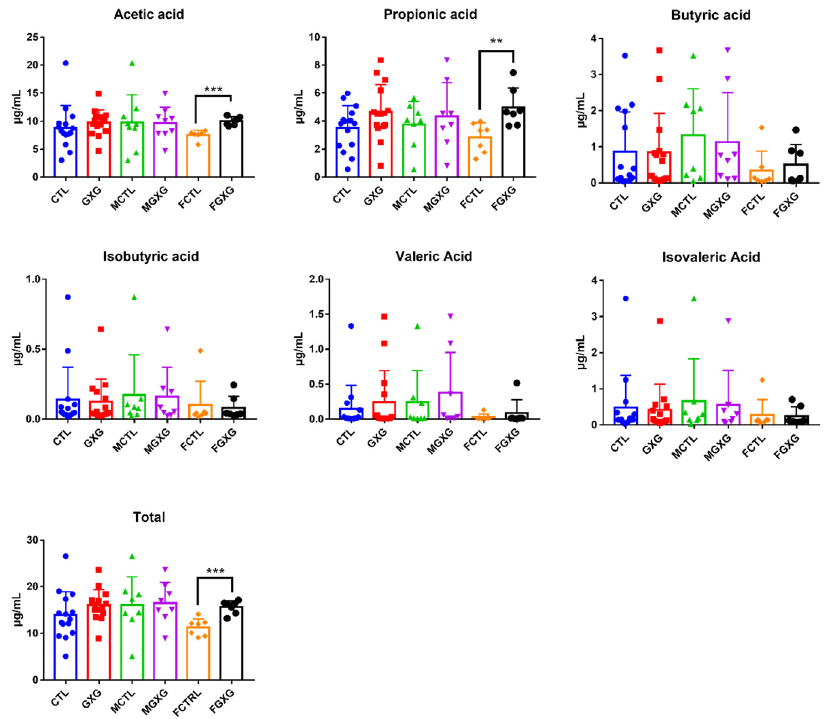
Figure 5. Effect of Dendrobium officinale polysaccharides on the production of short-chain fatty acids in the microbiota. ** p < 0.01. *** p < 0.005.